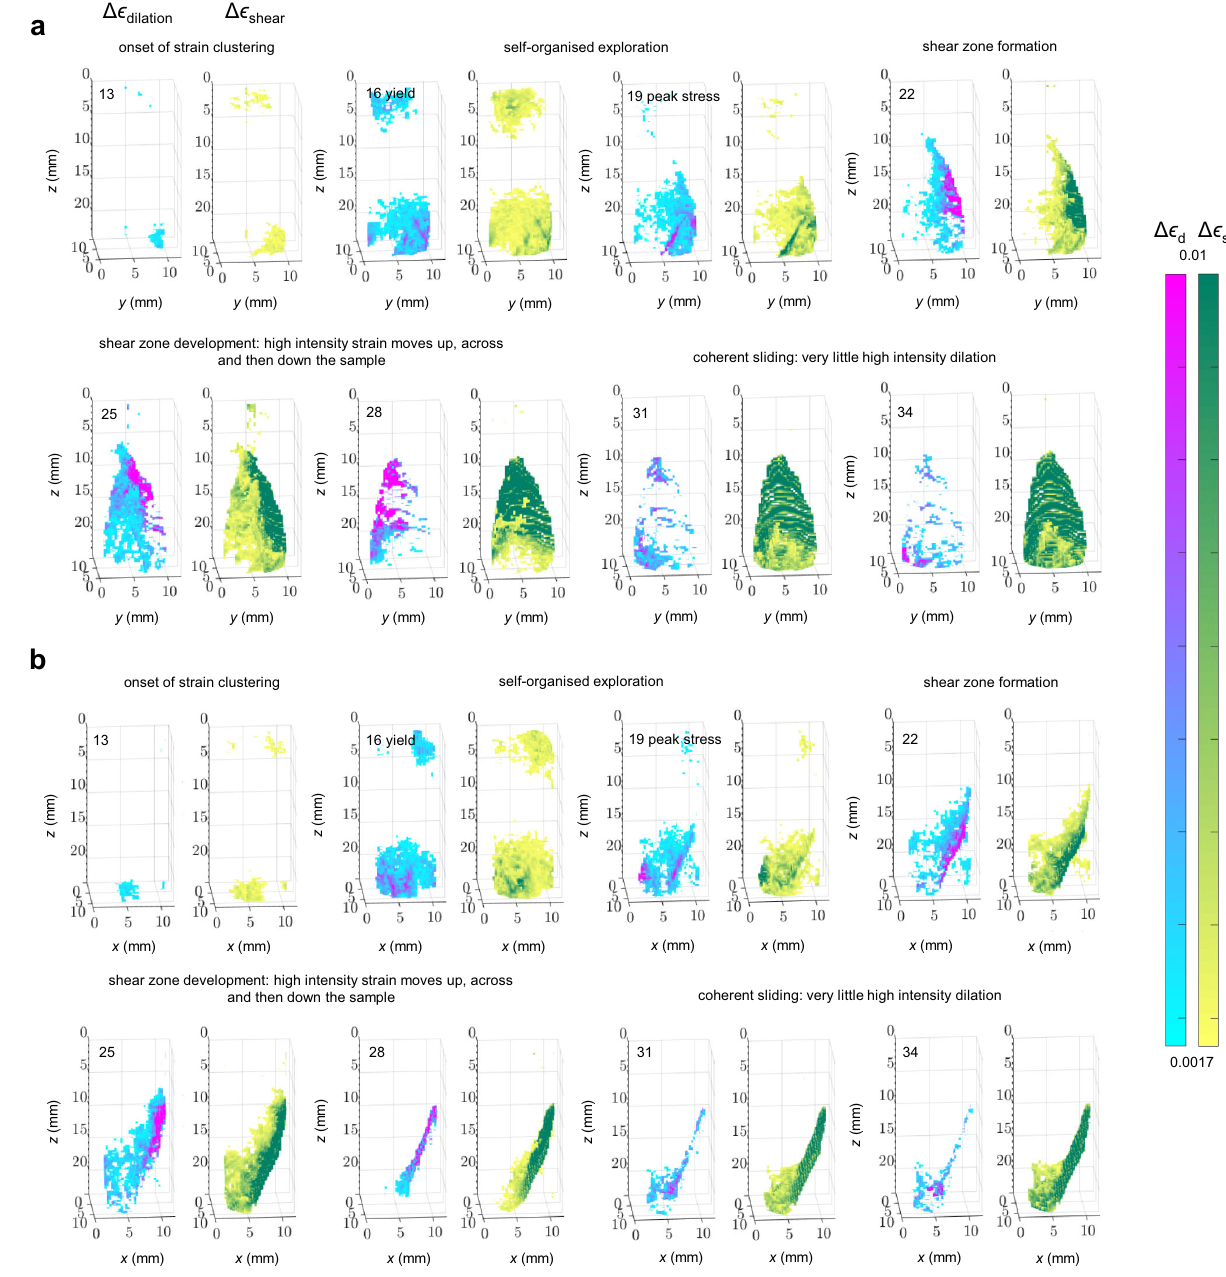
Fig.3|Selected3Dincrementalstrain fi eldsfromtheonsetofstrainclustering (marked in Fig. 1c). Incremental dilation, Δ ϵ d (blue-pink), and shear strain, Δ ϵ s (yellow-green), were calculated from digital volume correlation between suc- cessive pairs of tomographic volumes and are shown a parallel to strike ( y,z orientation)and b perpendiculartostrike( x,z orientation).Thelowerthreshold of 0.0017 was set at four standard deviations from the mean of the error dis- tribution of Δ ϵ s (Supplementary Fig. 6) and the upper threshold shows regions with strain >0.01 (maximum Δ ϵ s and Δ ϵ d were ~0.04; Supplementary Figs. 4 and 5). The thresholds were chosen to visually highlight regions of localised strain. Number labels correspond to those in Figs. 1 and 2, with the strain